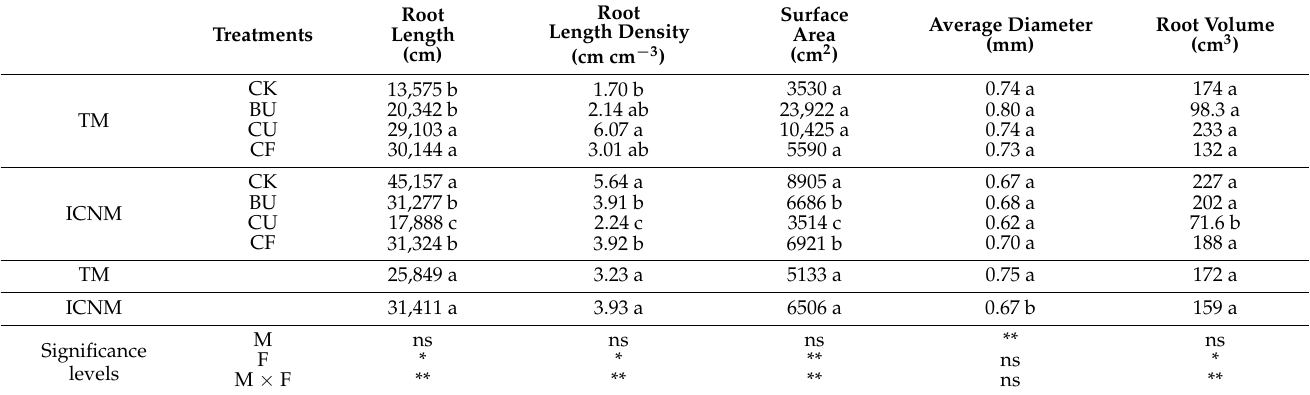
Table 4. Effects of different treatments on root architecture of